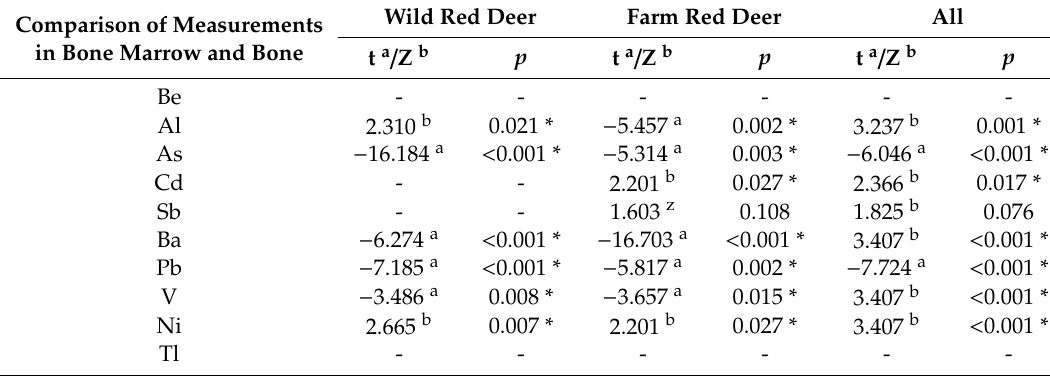
Table 2. Comparison of the concentrations of TE between the bone marrow and bones of the wild and farmed red